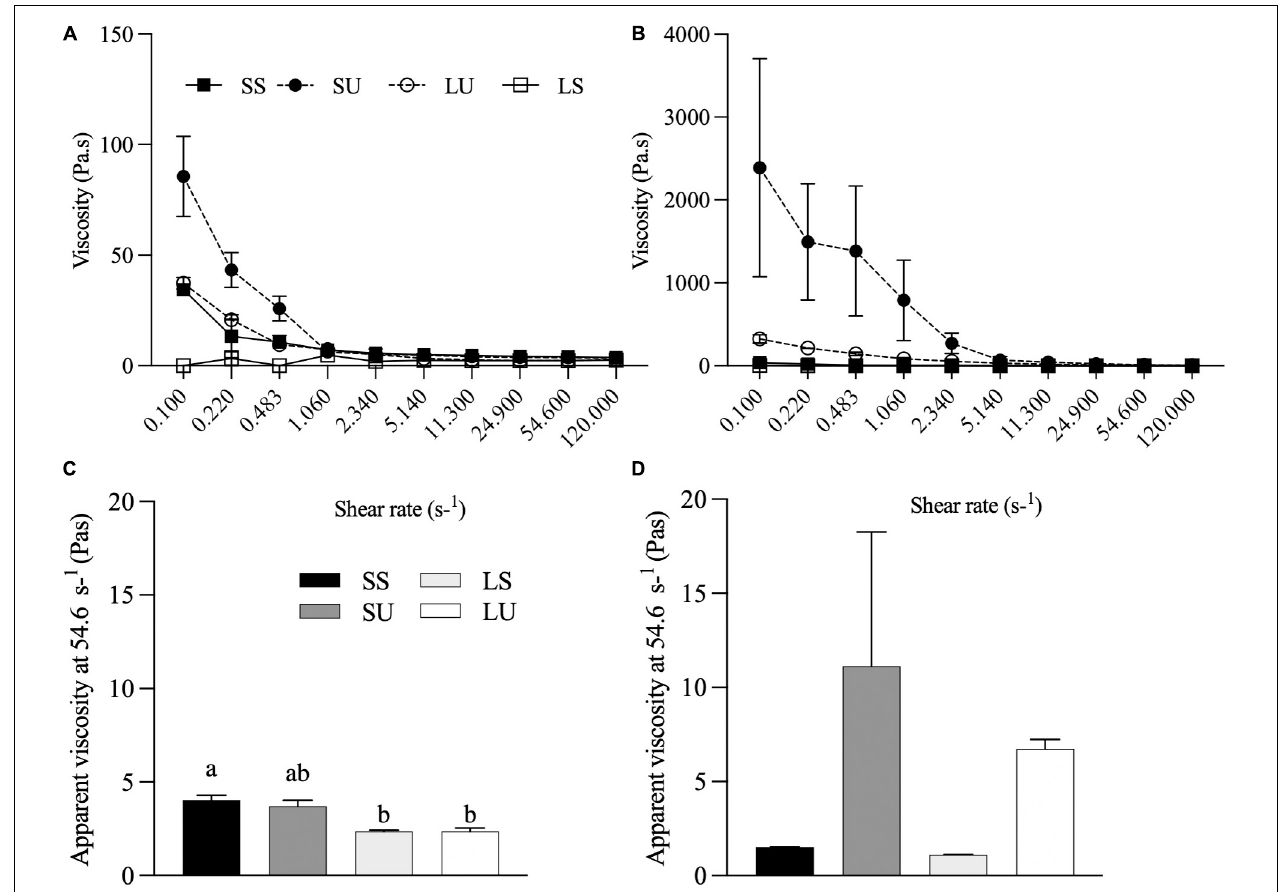
FIGURE 5 | Flow behavior of emulsions before (A) and after (B) 1 h of gastric digestion. Apparent viscosity (Pa • s) at 56.23 of emulsions before (C) and after (D) 1 h of gastric digestion ( n ≥ 2). Data reported as mean ± SEM. Bars with different letters are significantly different ( p > 0.05). LS, liquid lipid-acid stable emulsifier; LU, liquid lipid-acid unstable emulsifier; SS, solid lipid-acid stable emulsifier; SU, solid lipid-acid unstable emulsifier.